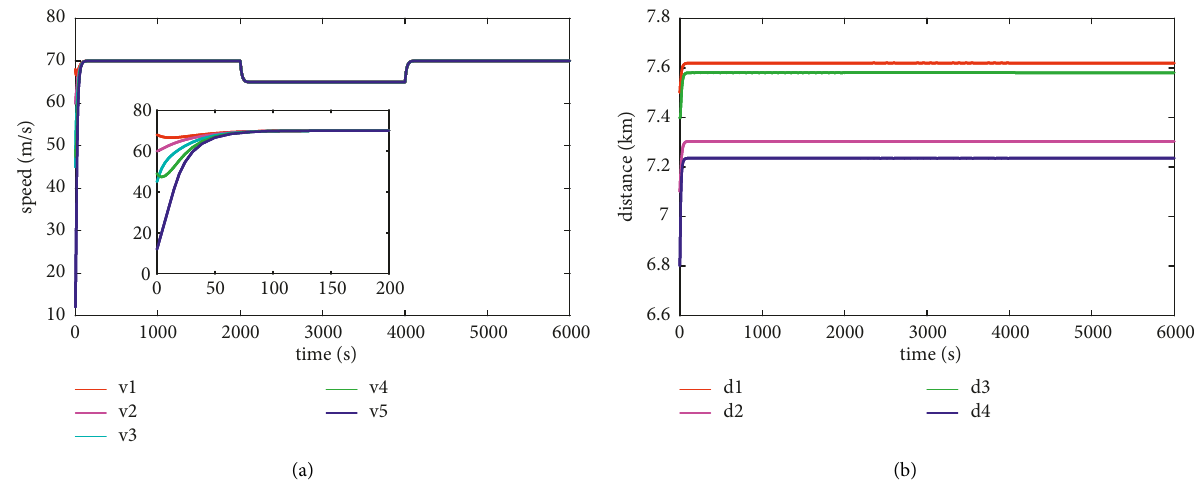
Figure 7: The simulation results of applying the cooperative control strategy in the study of [20], which keeps the distances in a safe range. (a) The speed curves. (b) The distance between adjacent